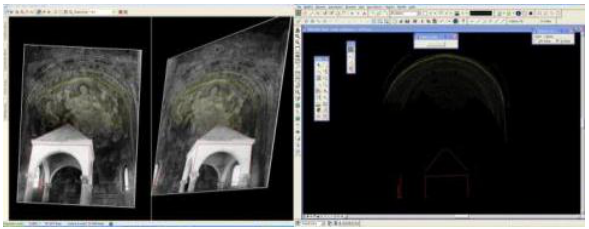
Figure 6. The two oriented images and the graphical results of the plotting of the old surface of the dome